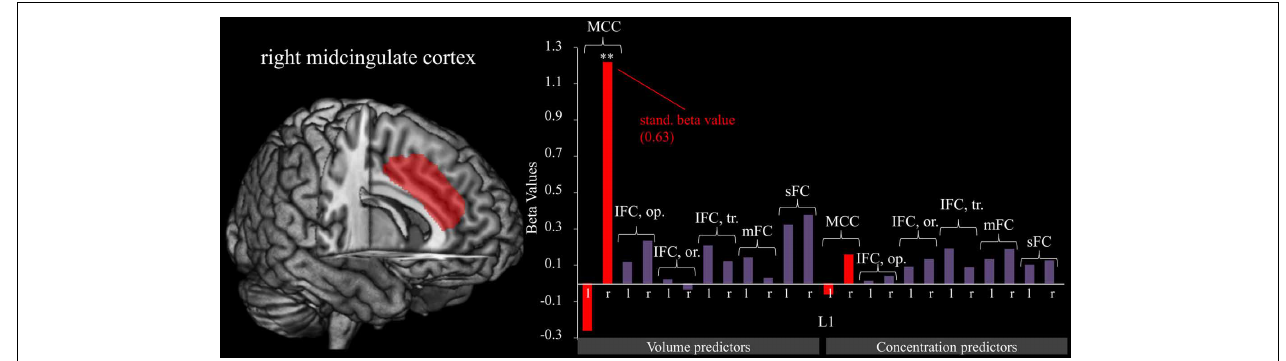
FIGURE 2 | Right midcingulate cortex predicts L1. The graphic shows the relation of fm-theta increases during training sessions (L1). Predictor variables include gray matter volumes (left) and concentrations (right). The figure reveals that the volume of the